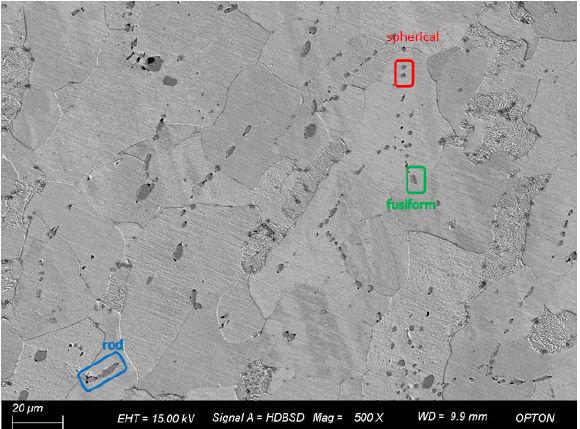
Figure 6. Morphology and quantity distribution of No. 3 steel inclusions.